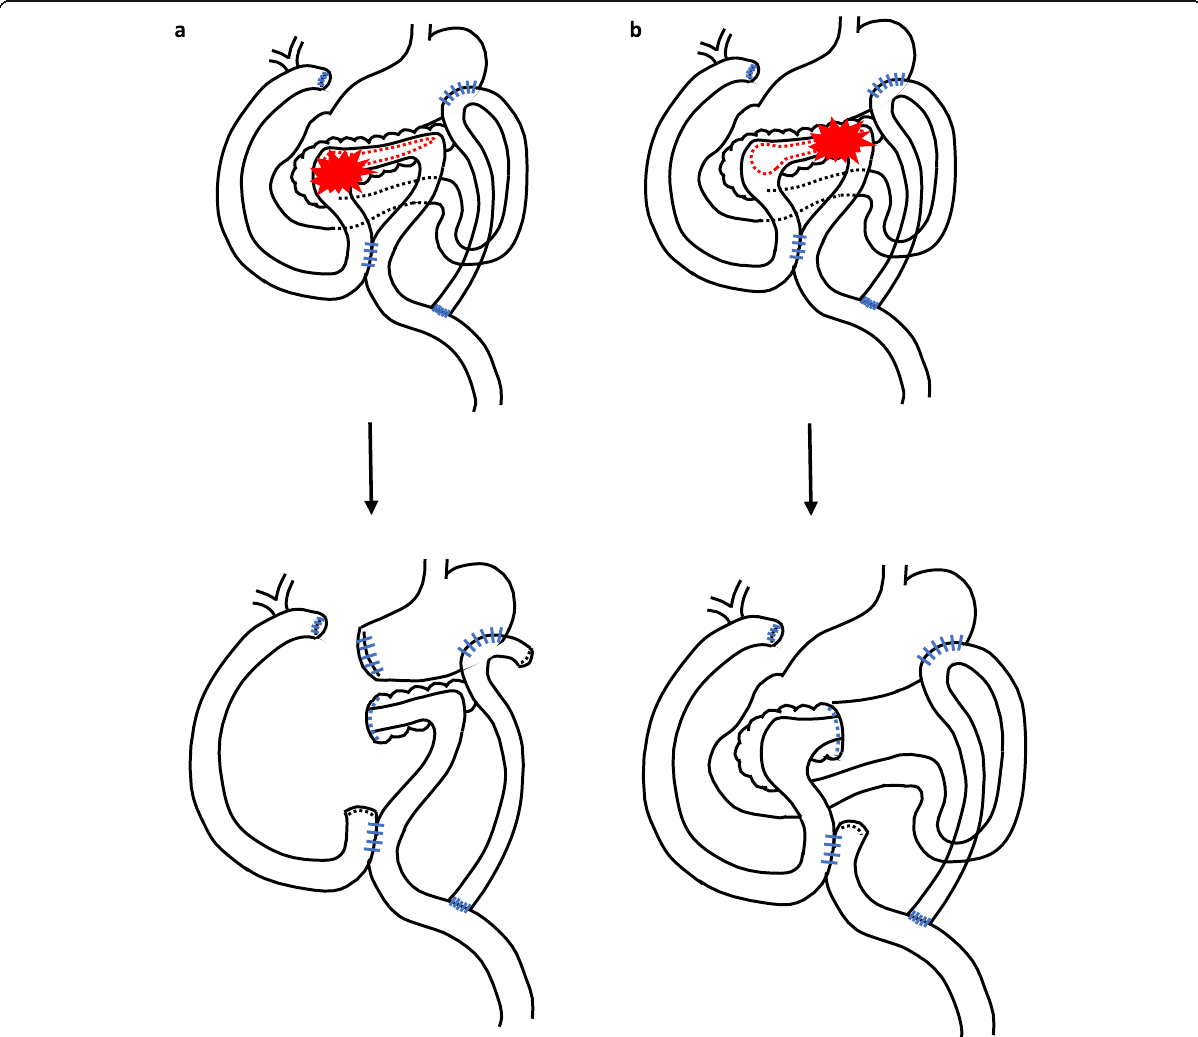
Fig. 8 Second operation for pancreatic cancer after our procedure. If pancreaticoduodenectomy ( a ) or distal pancreatectomy ( b ) will be performed, reconstruction of the bile duct or jejunum will not be